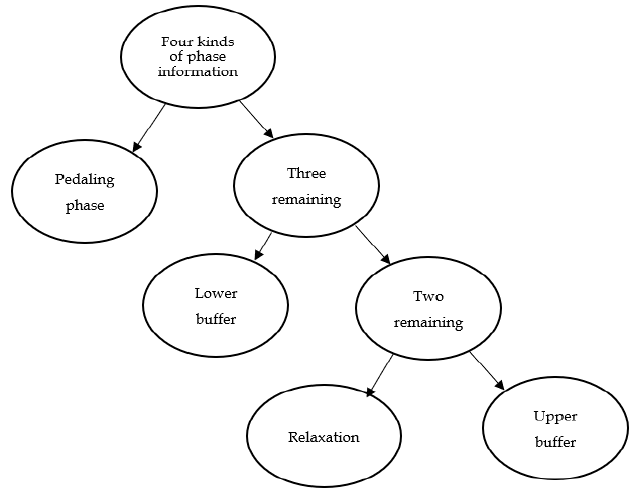
Figure 10. Schematic diagram of binary classification.